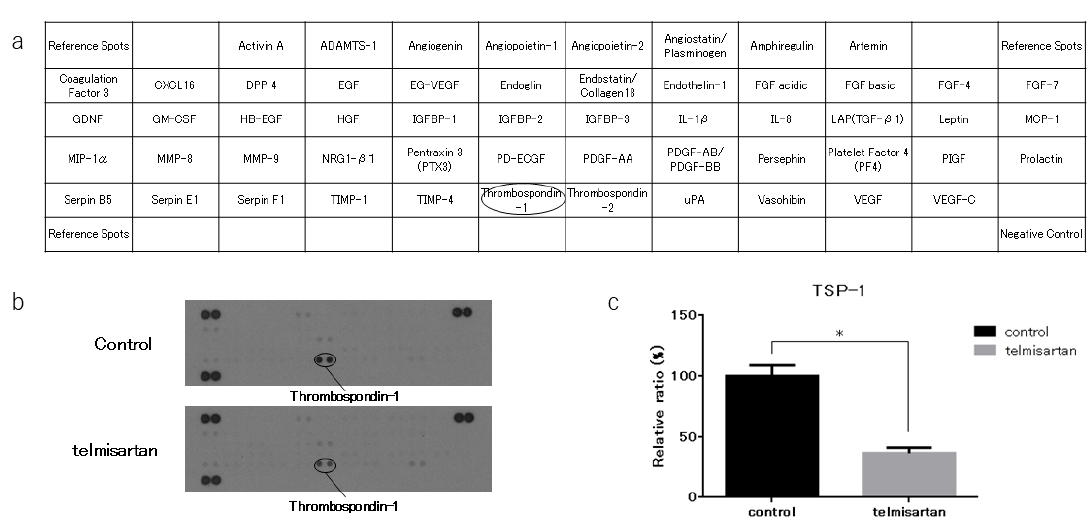
Figure 6. Angiogenesis antibody array in KYSE180 cells. ( a ) Template shows locations of angiogenesis antibodies on human angiogenesis array. ( b ) TSP-1 expression was decreased in KYSE180 cells treated with 50 µ M telmisartan at 24 h. ( c ) Densitometric ratio of telmisartan-treated group to the non-treated group for TSP-1 spots. * p < 0.01.